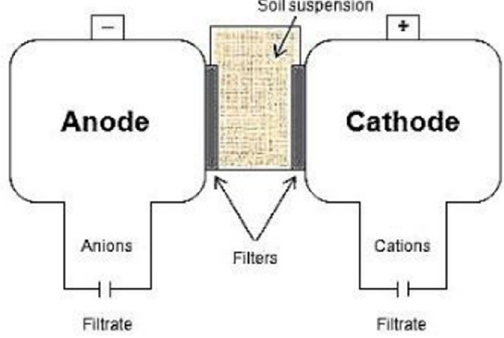
Figure 1. The electro-ultrafiltration (EUF) chamber. Table 3. Released amounts after 5,10, 15, 20, and 25 min of electro-ultrafiltration in 0,002 M DTPA.